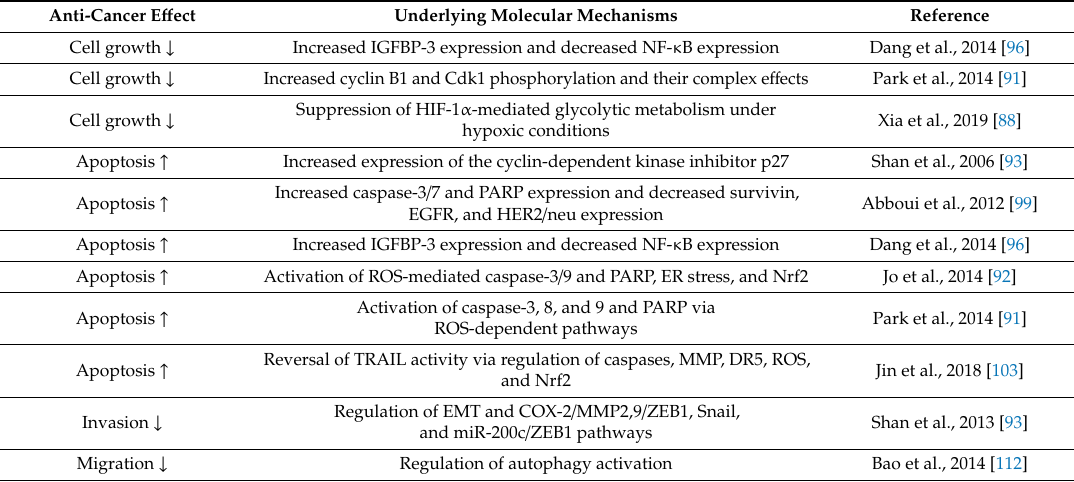
Table 3. In vitro molecular mechanisms of the anti-cancer e ff ects of